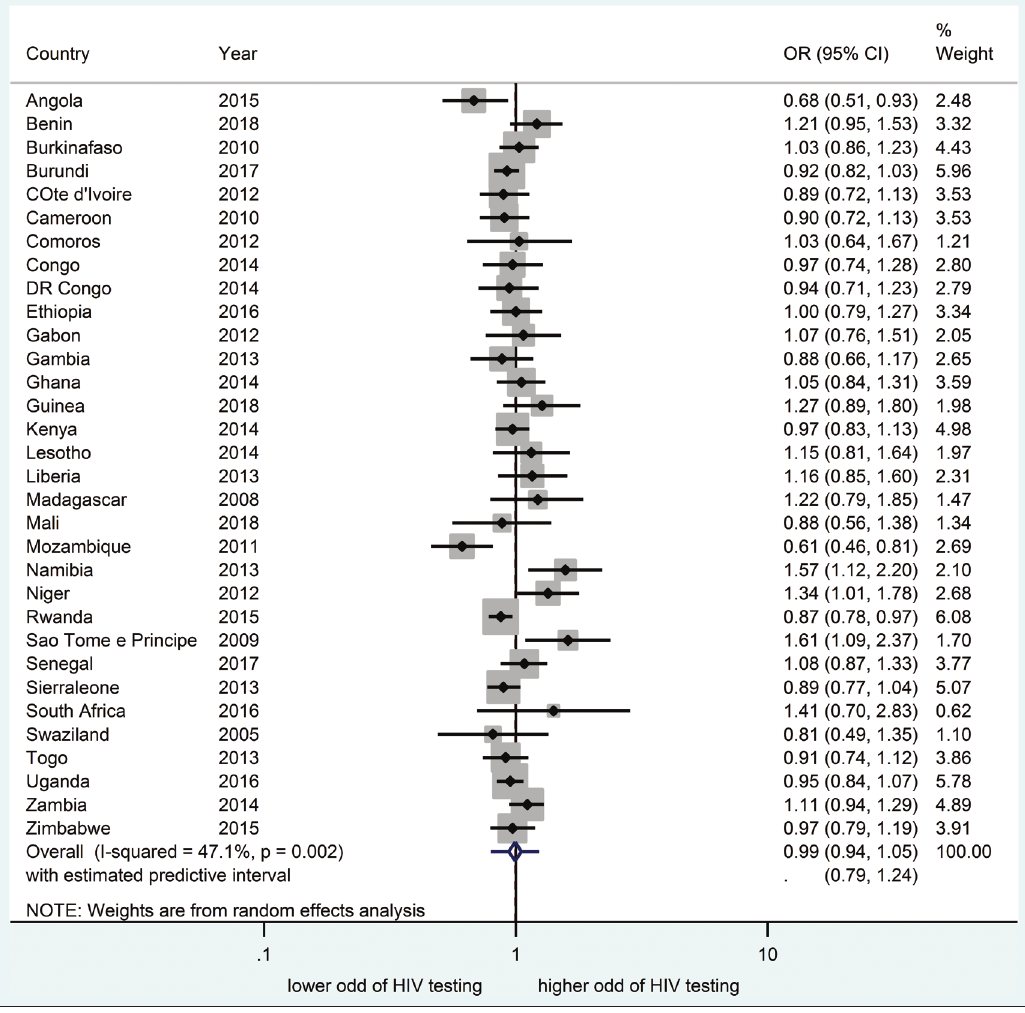
Figure 3: Forest plot showing the effect of wife beating attitude on HIV